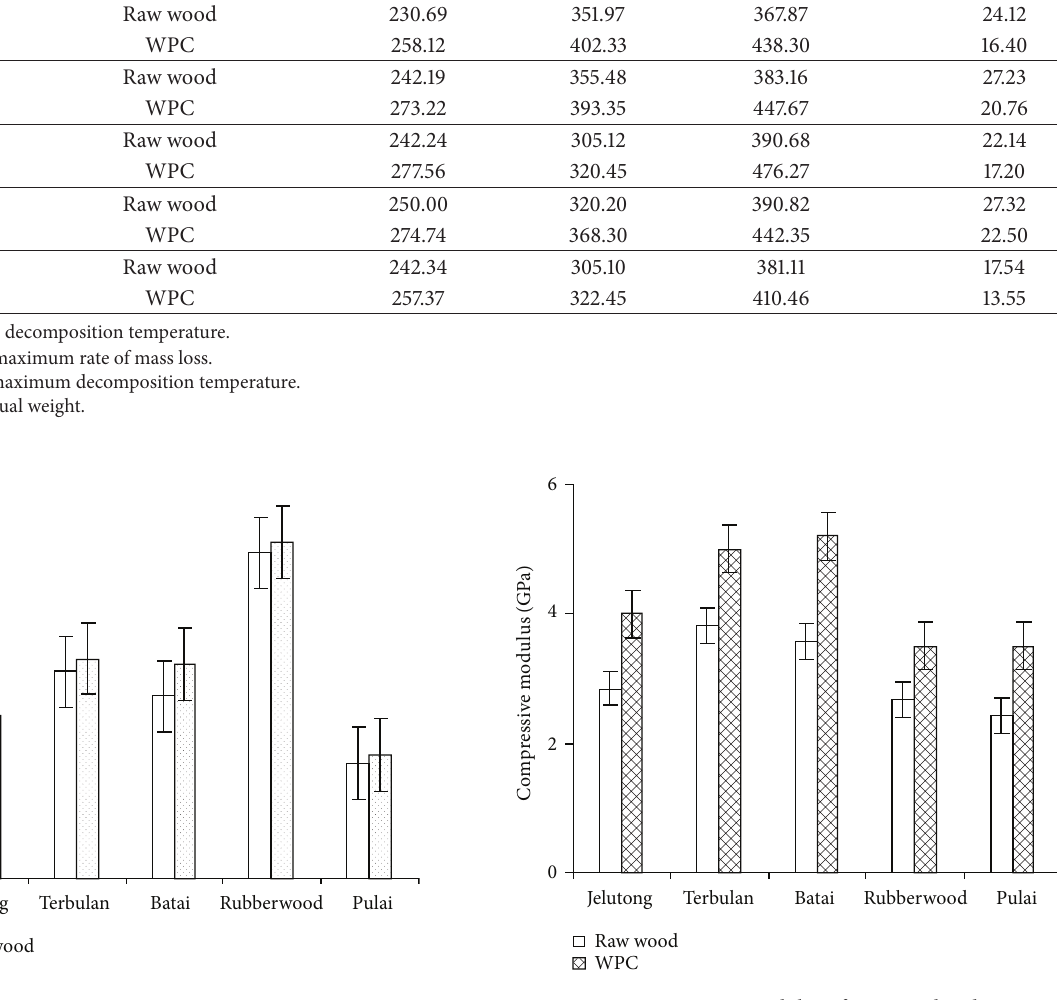
Figure 4: Modulus of elasticity of raw wood and WPCs. Figure 5: Compressive modulus of raw wood and